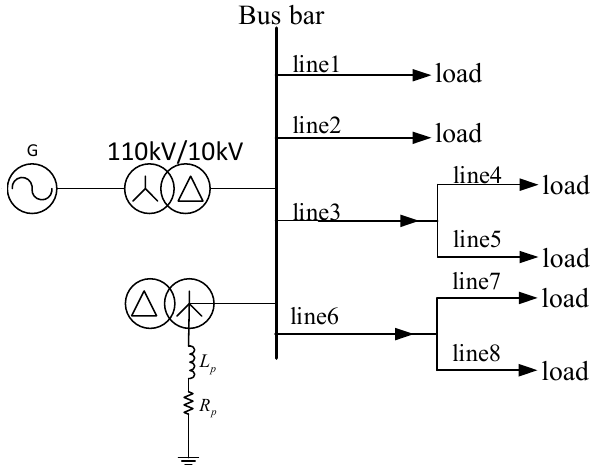
Figure 12. Distribution network. Table 2. Simulation model line parameters.